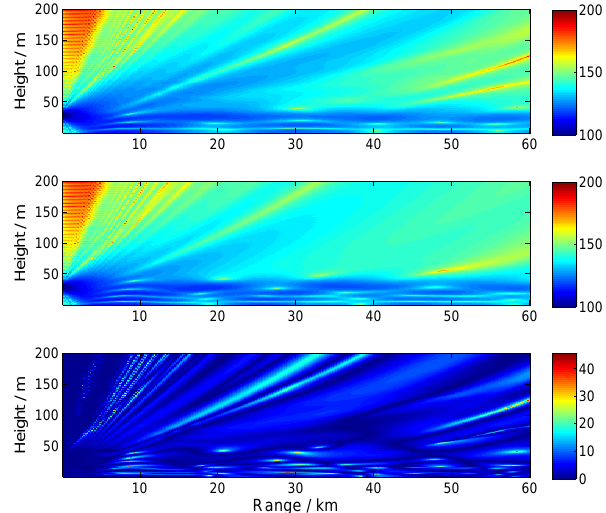
Fig. 5. Coverage diagrams (dB) of propagation loss corresponding to the helicopter profiles (top), estimated profiles (middle), and the absolute difference between the above two diagrams